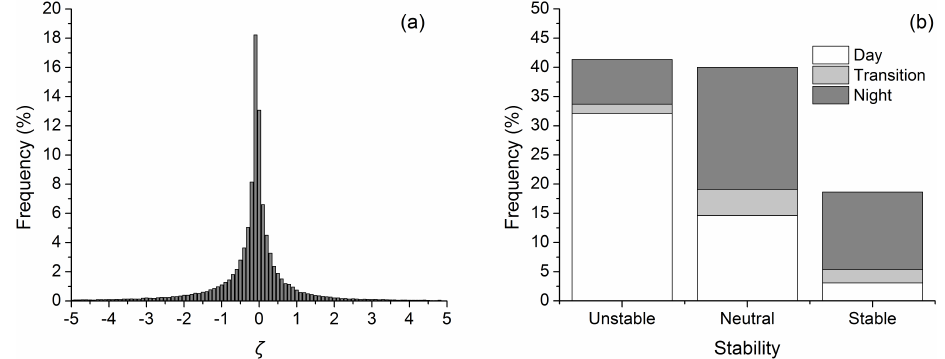
Fig. 3. Frequency histogram of atmospheric stability in 0.1 bins during the whole measurement period (a) and categorized by the time of day (b) . Transition period was defined by two hours centered on sunrise/sunset. The stability conditions were divided into three categories: unstable ( ζ < − 0 . 05), near neutral or weakly stable ( − 0 . 05 < ζ < 0 . 2) and stable ( ζ > 0 . 2). The atmospheric stability is usually in the near neutral or weakly stable condition during the night.